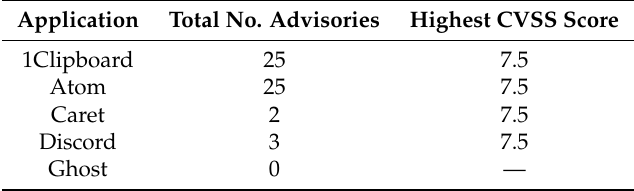
Table 1. An automated scan of the applications against the Node Security Platform advisories